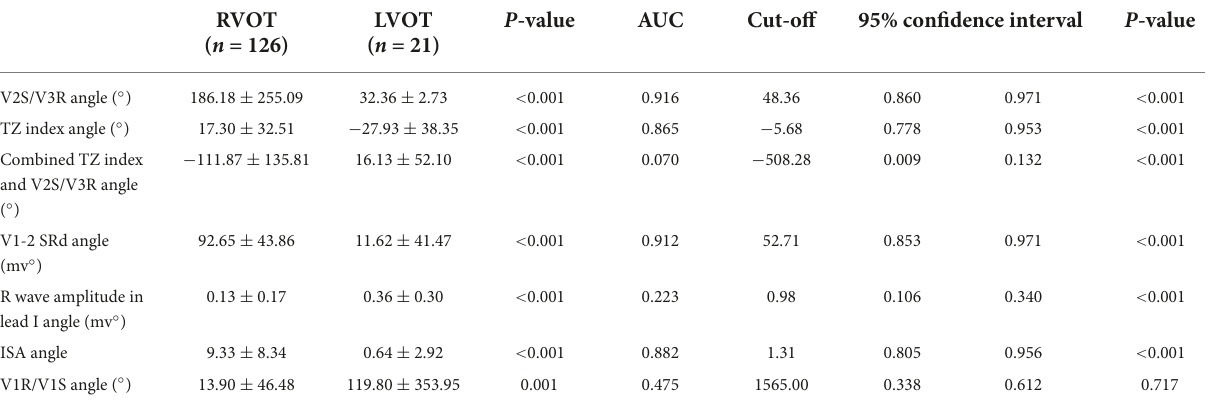
TABLE 4 The angle-corrected ECG algorithms applied to the retrospective cohort ( n = 147). P -value AUC Cut-off 95% confidence RVOT LVOT ( n = 126) ( n = 21)